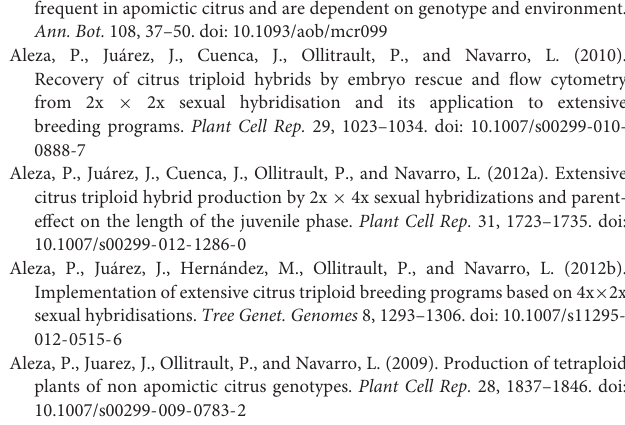
microspores from the tetrads, a JIM5 fluorescence signal was observed in the aperture sites (arrows) and in the early intine. (D,H) When the size of vacuolate